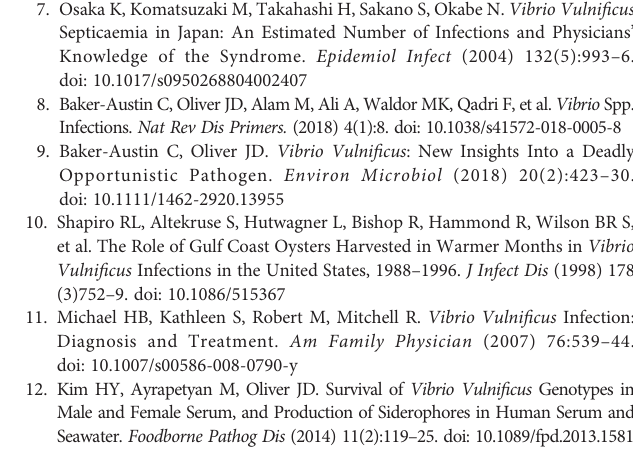
Supplementary Figure 1 | Cytokine concentrations in different periods. (A) . Cytokine concentrations in plasma 9 hours and 5 days post gavage (n = 10). The concentrations of cytokines were standardized by z-score, with red indicating higher concentration and blue indicating lower concentration. (B, C) . The concentration of IL-18 and IL-4 (ns P>0.05, **P<0.01,